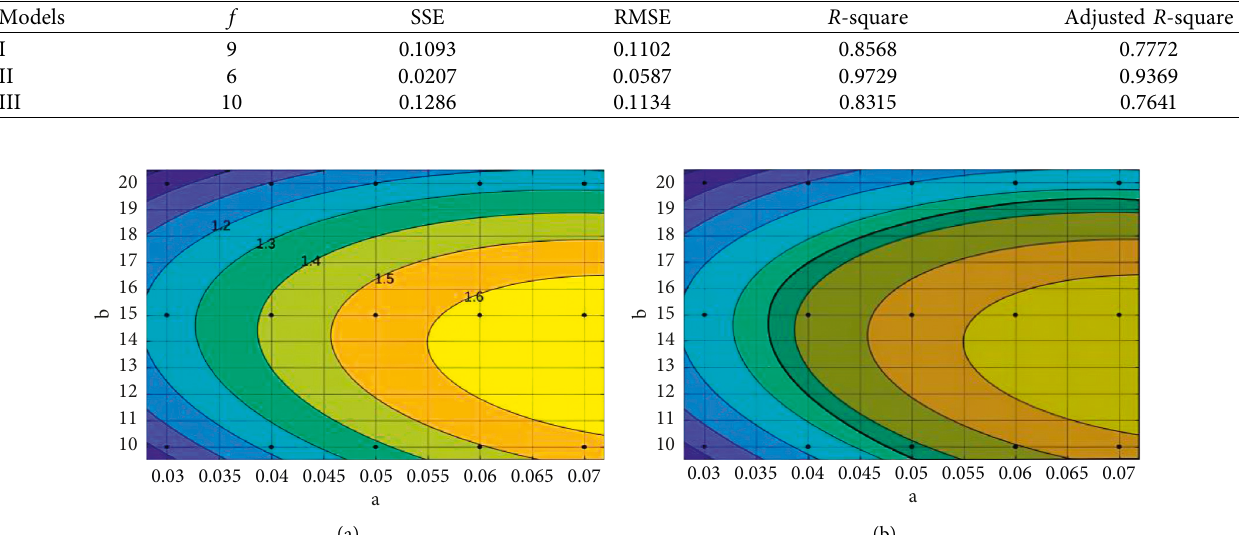
Figure 7: 7 days UCS contour map of MOC and OPC solidified soils. (a) Contour map of MOC solidified soil. (b) Comparison of MOC and OPC solidified soil contour